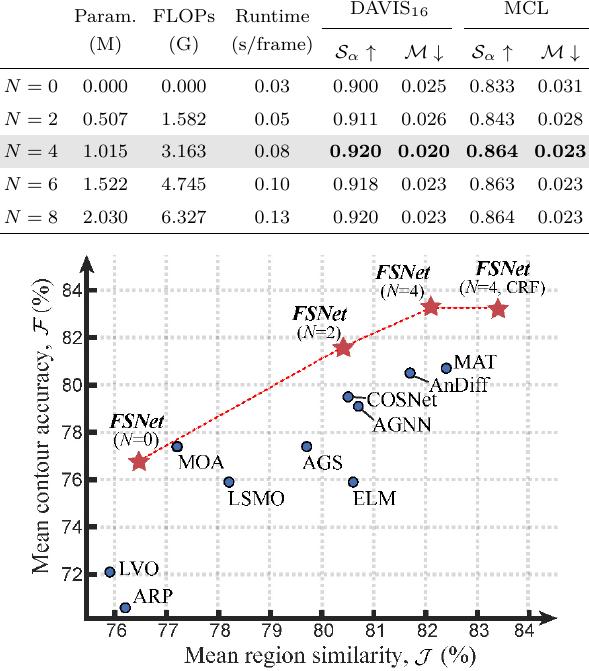
Effect of the number ( N ) of BPMs on results on DAVIS 16 [35] and MCL [85], focusing on number of parameters and FLOPs for BPMs, and runtime of FSNet Param. FLOPs Runtime